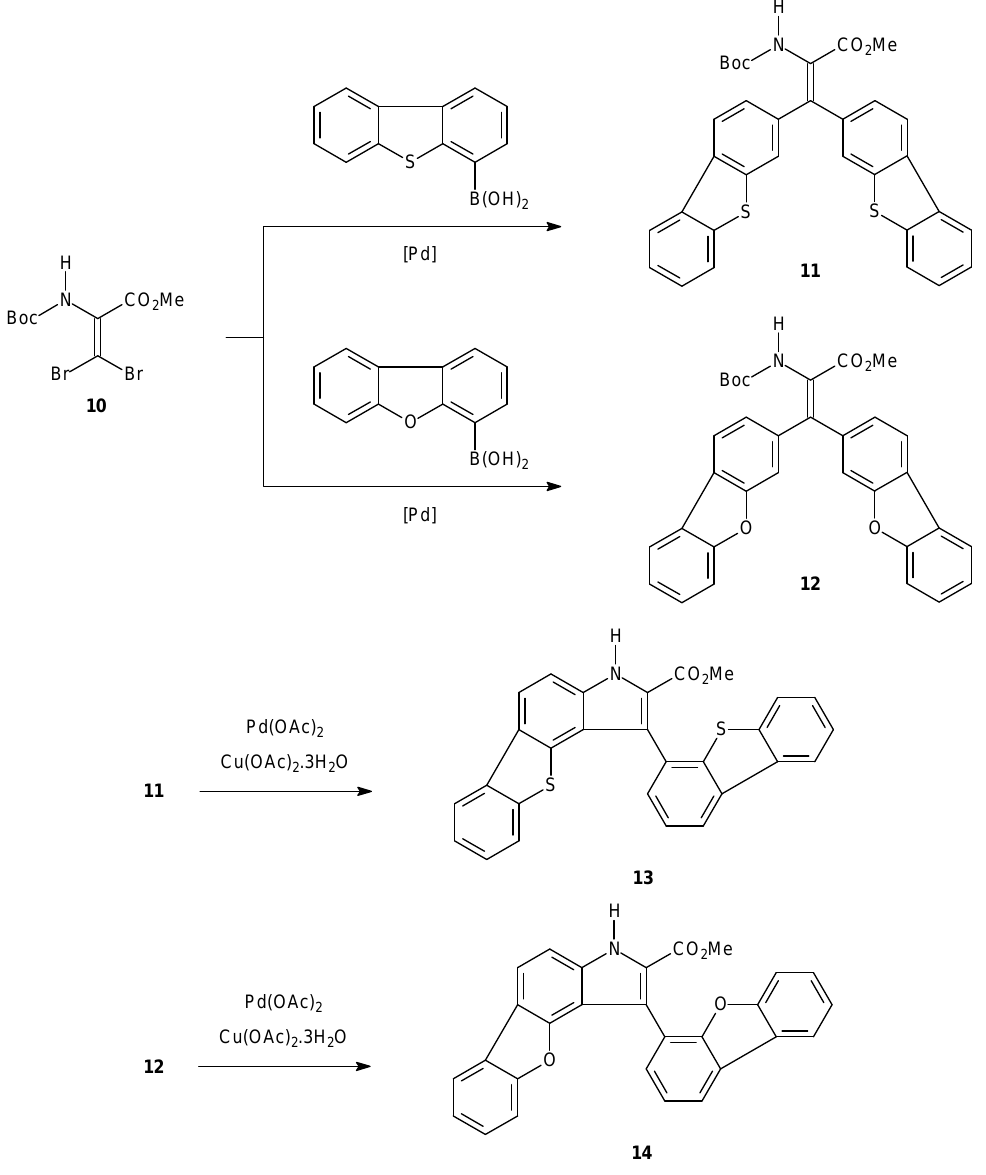
Two new tetracyclic neutral and highly polar compounds were synthesized by an intramolecular C- N metal-assisted cyclization. The desired dyes were prepared by a bis-Suzuki coupling of a  ,  - dibromodehydroalanine derivative and dibenzothien-4-yl and dibenzofur-4-yl boronic acids. Scheme 4. Synthesis of fluorescent benzothienoindole and a benzofuroindole tested as intercalating agents.